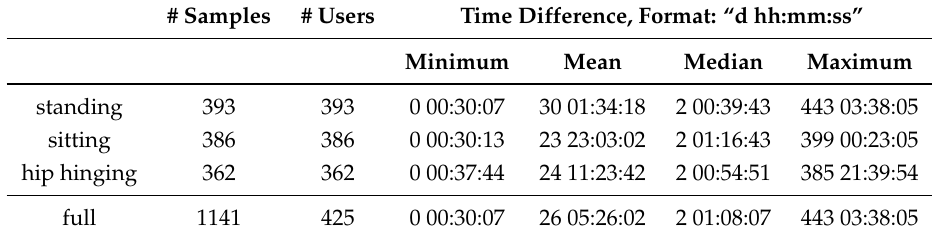
Table 1. General statistics of the data basis used for our analysis. The column labelled # samples contains information on the number of snapshot pairs per position. The # users states how many different users recorded such pairs. The last four columns state the minimum, average, median, and maximum time passed between the snapshots in each pair. Time is displayed as a tuple of days (d), hours (hh), minutes (mm), and seconds